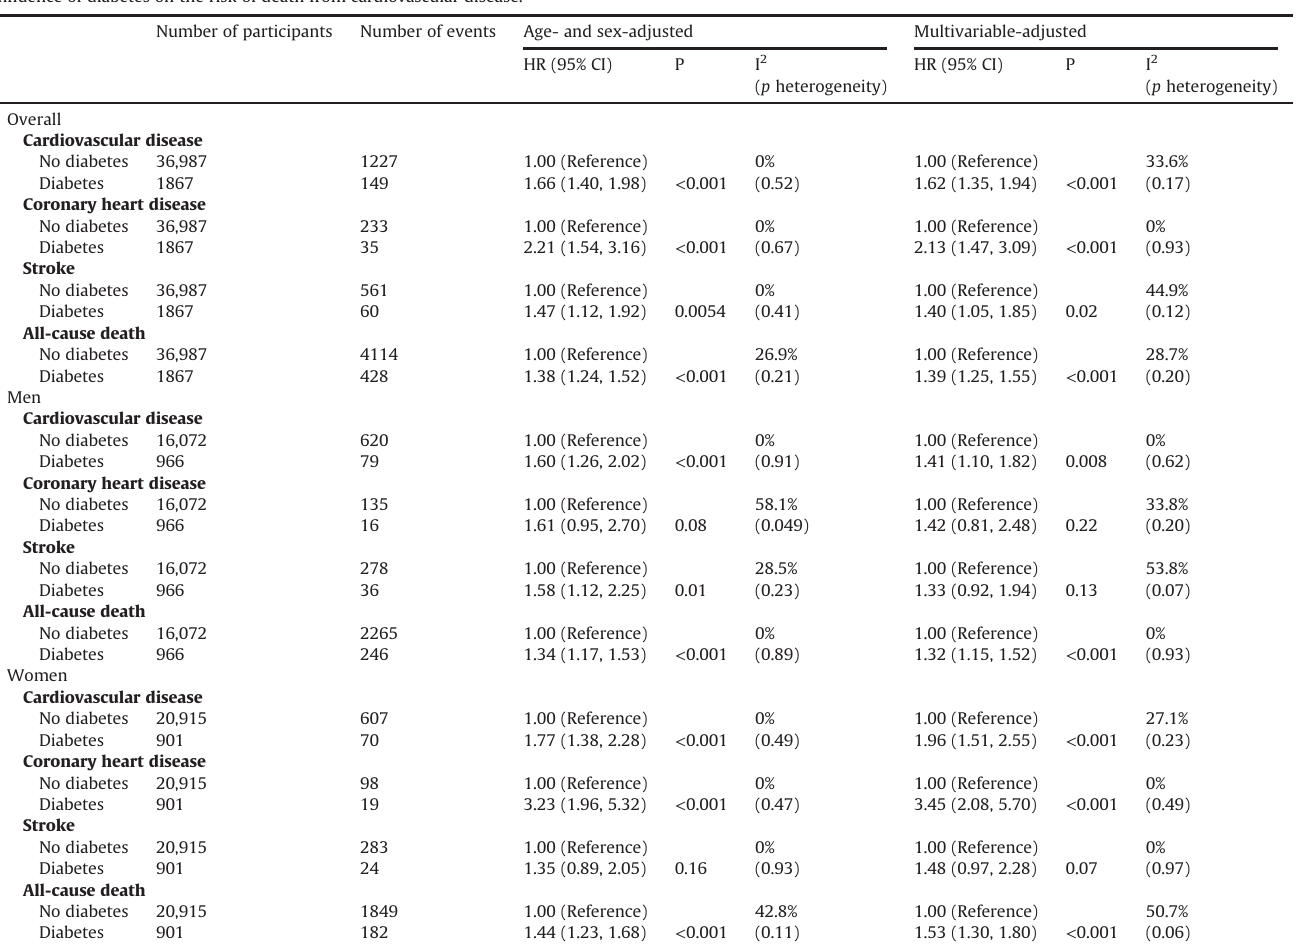
Table 3 In fl uence of diabetes on the risk of death from cardiovascular